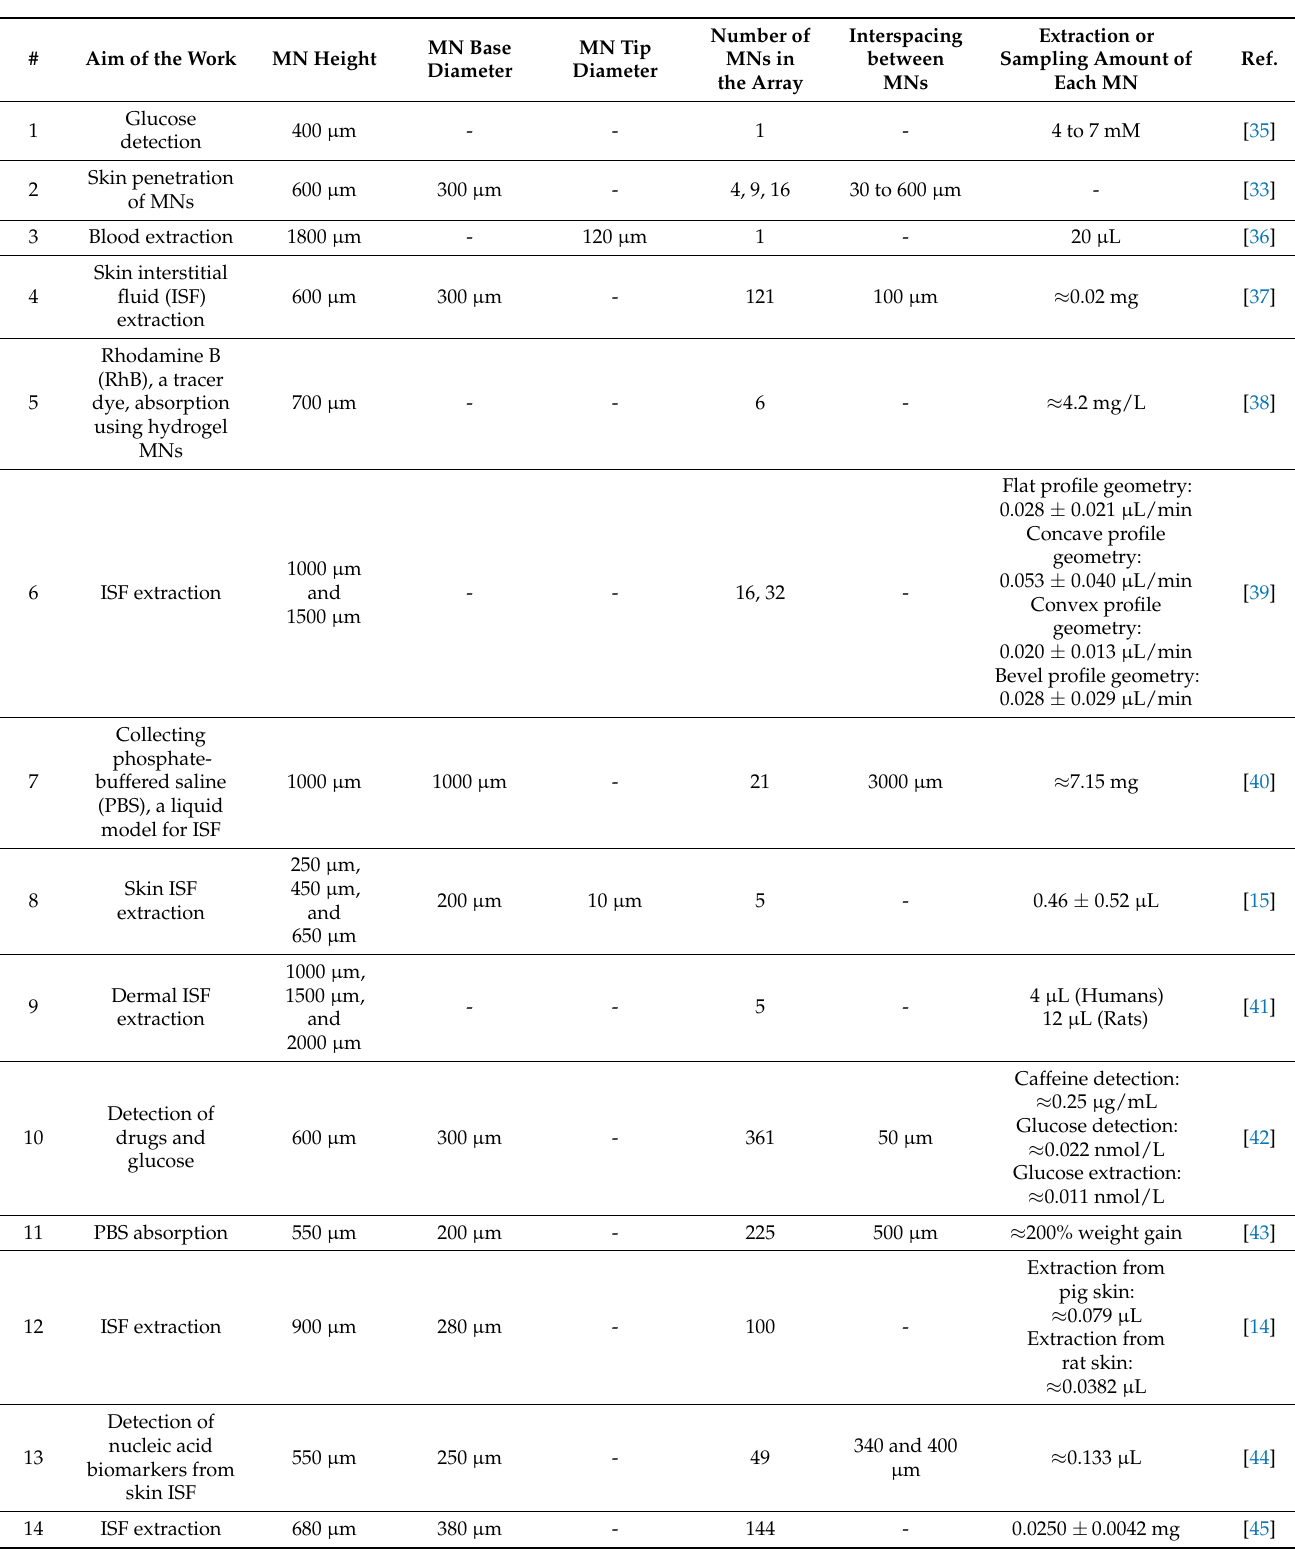
Table 1. Geometrical properties of experimentally reported microneedle arrays (MNAs) with applications in sampling or extraction of body